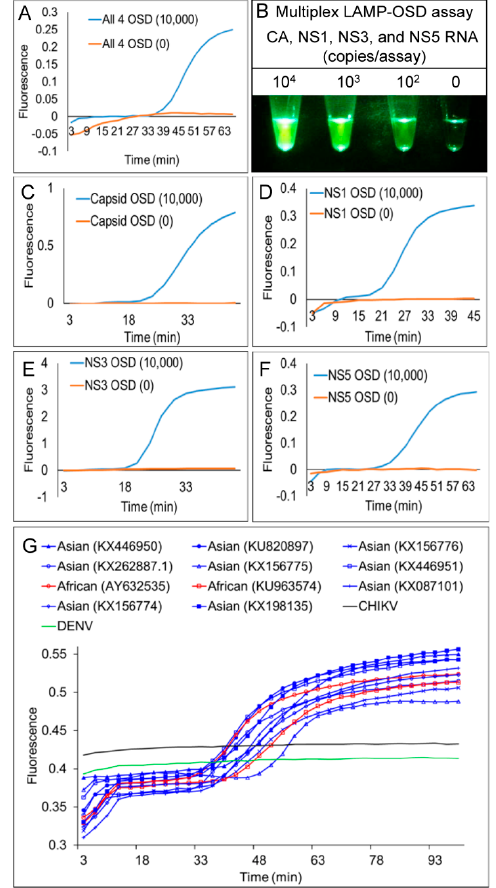
Figure 4. Simultaneous detection of four Zika virus genes using multiplex reverse transcription degenerate LAMP-OSD (multiplex LAMP-OSD) assay. ( A ) Real-time multiplex LAMP-OSD—synthetic RNA mixtures containing indicated copies of each of the four ZIKV synthetic RNA templates ( CA , NS1 , NS3 , and NS5 ) were amplified using multiplex LAMP-OSD assays containing 21 degenerate primers and 4 degenerate OSD probes for simultaneous LAMP amplification and sequence-specific detection of all four ZIKV targets. OSD fluorescence signals measured in real-time during LAMP amplification are depicted as blue (10,000 copies each of CA , NS1 , NS3 , and NS5 RNA) and orange (0 ZIKV RNA; 10 6 copies of DENV RNA) traces. The x -axis depicts the duration of LAMP amplification. ( B ) Endpoint multiplex LAMP-OSD assay with visual detection—synthetic RNA mixtures containing indicated copies of each of the four ZIKV synthetic RNA templates ( CA , NS1 , NS3 , and NS5 ) were amplified using degenerate multiplex LAMP-OSD assays. OSD fluorescence was imaged after 90 min of amplification using a cellphone. Numbers above each assay tube indicate the RNA template copies used. The reaction with ‘0’ ZIKV RNA received 10 6 copies of DENV RNA. (C-F) Performance of individual assays in the multiplex LAMP-OSD system—synthetic RNA mixtures containing indicated copies of each of the four ZIKV synthetic RNA templates ( CA , NS1 , NS3 , and NS5 ) were amplified using multiplex LAMP-OSD assays containing LAMP primers for all four targets but only one type of OSD for either capsid ( C ), NS1 ( D ), NS3 ( E) , or NS5 ( F ) amplicons. OSD fluorescence signals measured in real-time during LAMP amplification are depicted as blue (10,000 copies each of CA , NS1 , NS3 , and NS5 RNA) and orange (0 ZIKV RNA; 10 6 copies of DENV RNA) traces. The x -axis depicts the duration of LAMP amplification. ( G ) Detection of Asian and African lineage ZIKV genomic RNA using degenerate multiplex LAMP-OSD assays. Genomic RNA from DENV, CHIKV, or Asian or African lineage ZIKV (indicated by their GenBank accession numbers) were used as templates for amplification. Real-time OSD fluorescence signals are depicted as blue (Asian), red (African), black (CHIKV), and green (DENV) traces. The x -axis depicts the duration of LAMP amplification. For all experiments, representative results from three replicate tests are